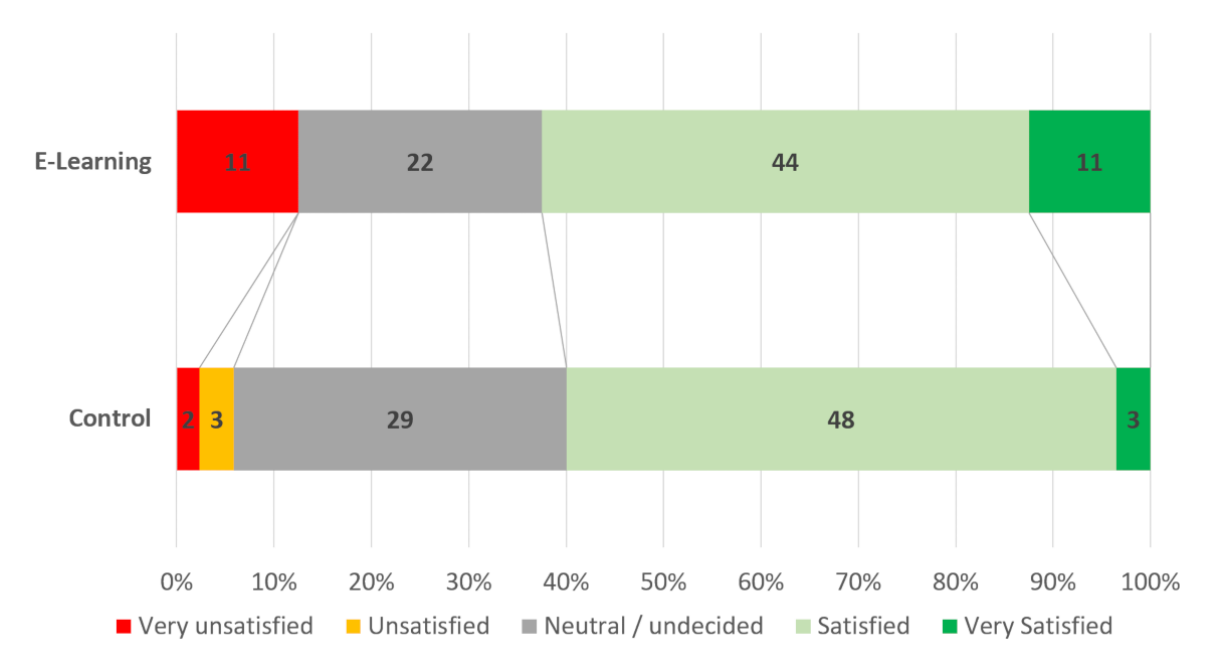
Figure 4. Participant